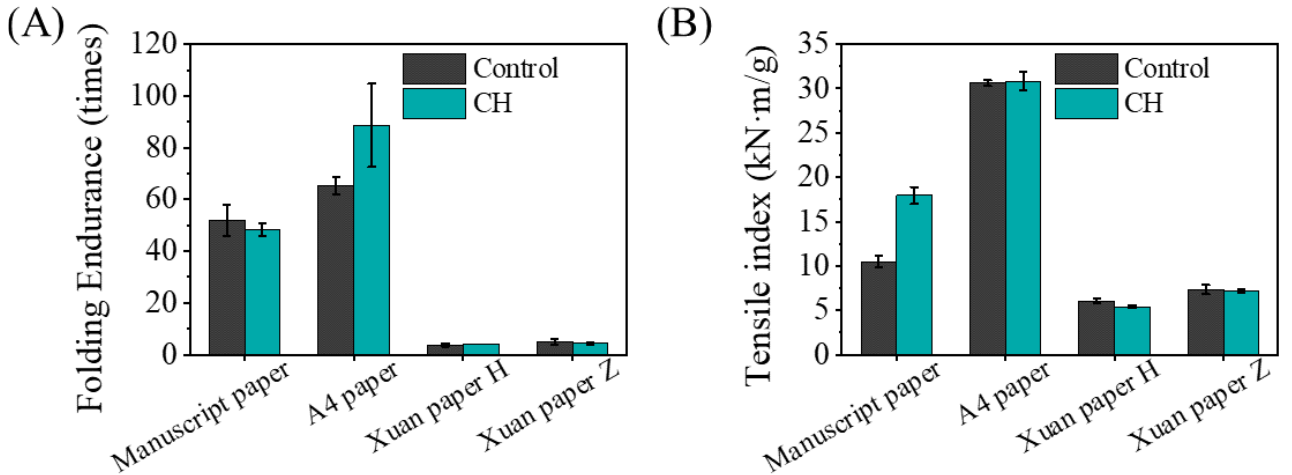
Figure 8. The comparison of control (untreated) paper and reinforced paper CH on the paper strength index, ( A ) folding endurance, and ( B ) tensile index.